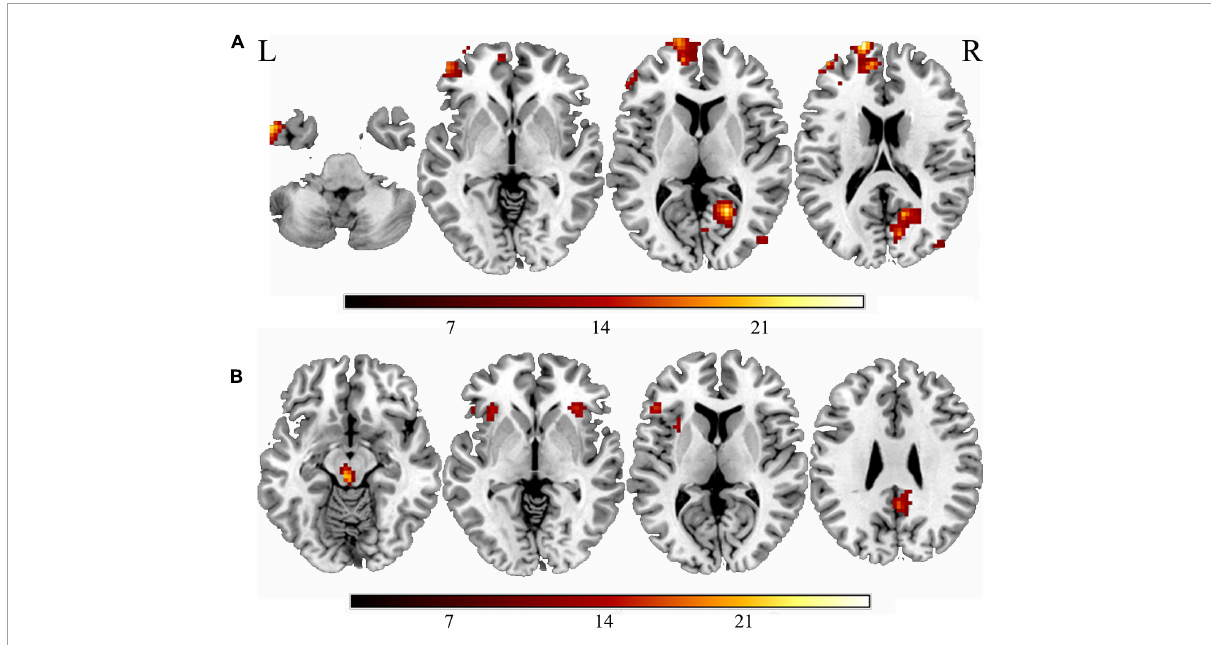
FIGURE1 The main effect of smoking or weight. (A) The main effect of smoking; (B) the main effect of overweight. “L” means the side is to the left and “R” means the side is to the right.